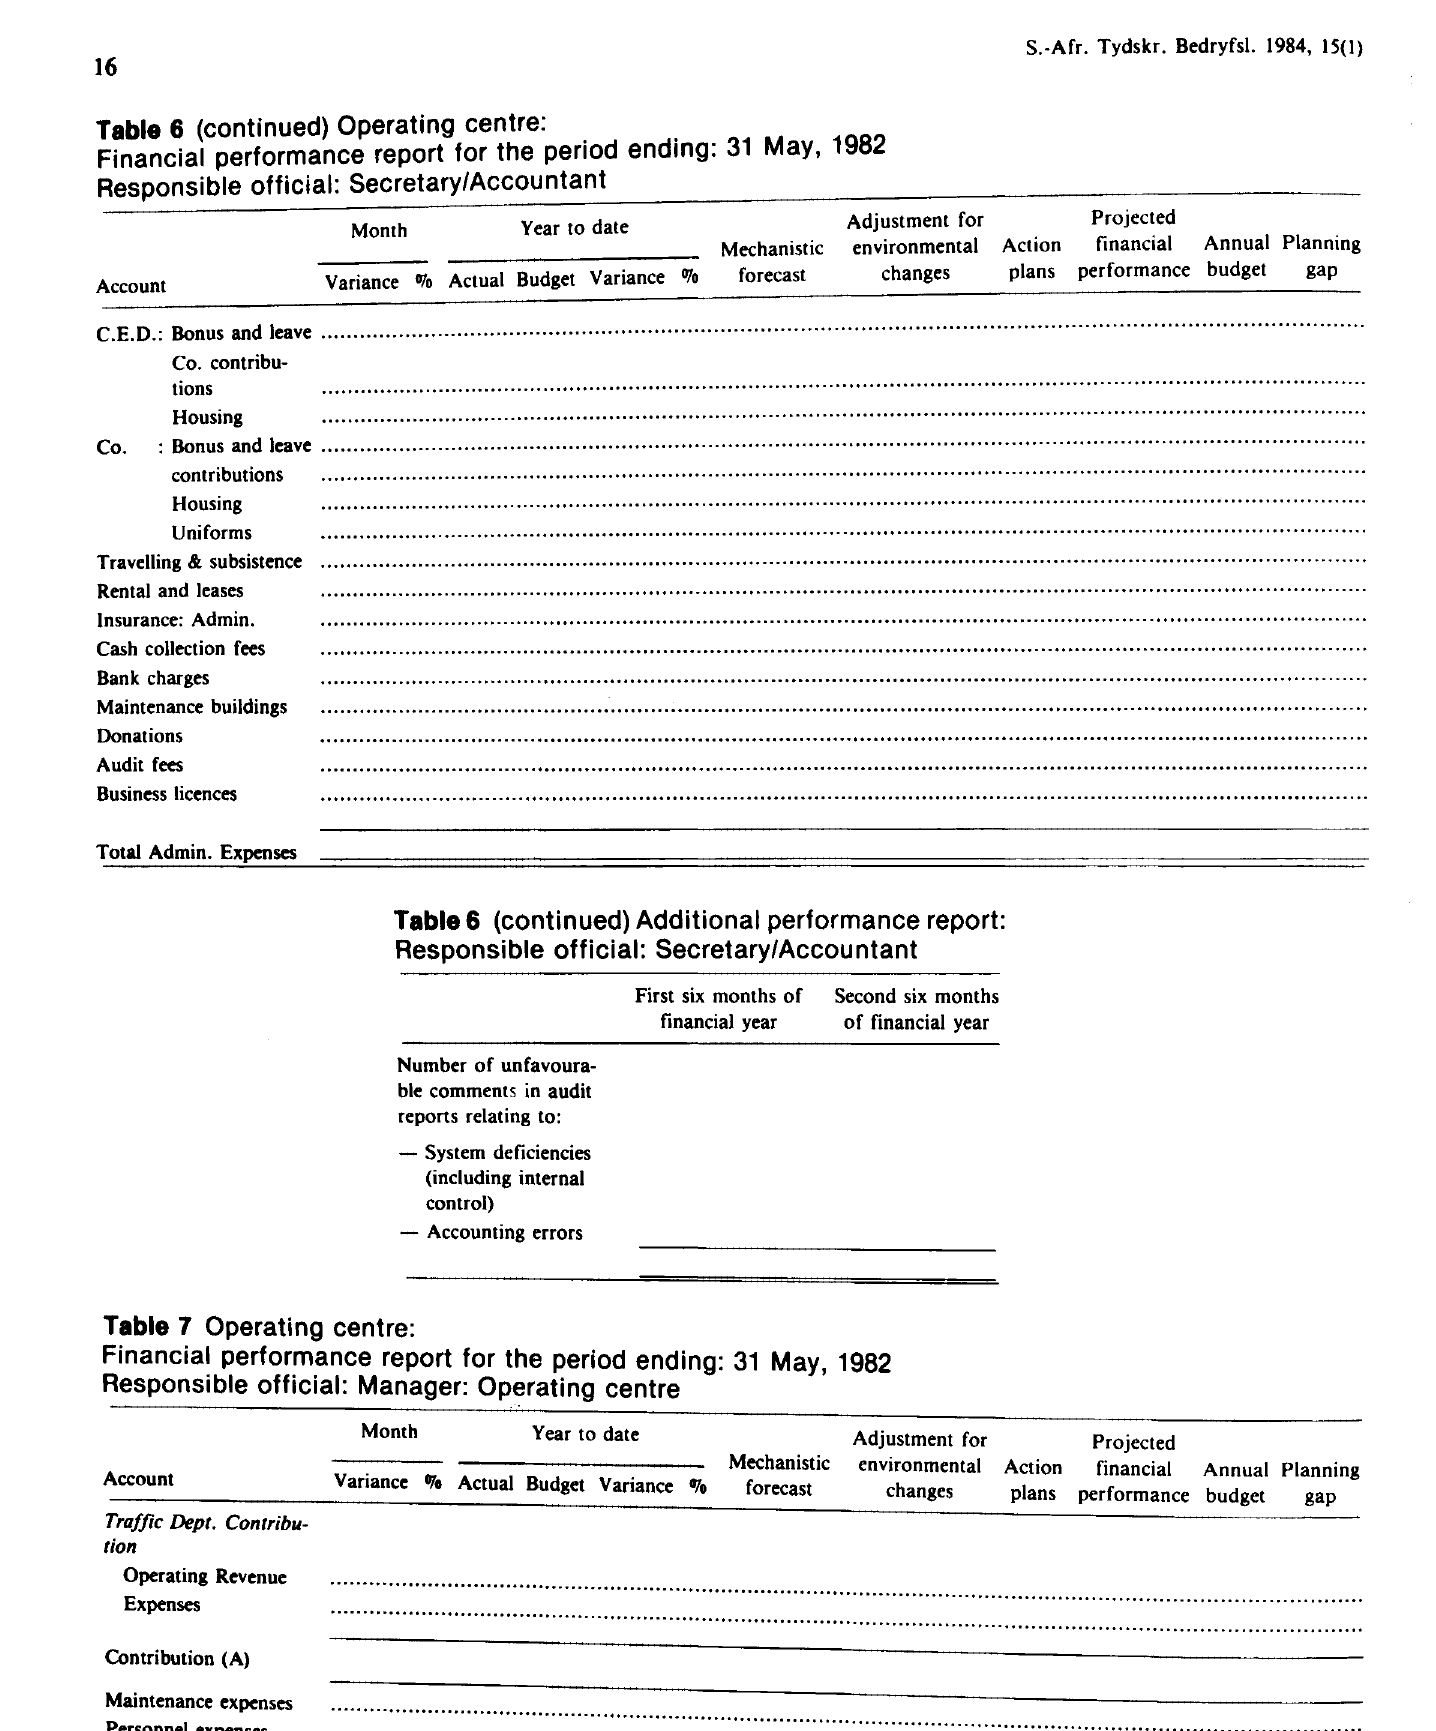
Table 7 Operating centre: Financia~ perfor~~nce report for the period ending: 31 May, 1982 Responsible off1c1al: Manager: Op~rating